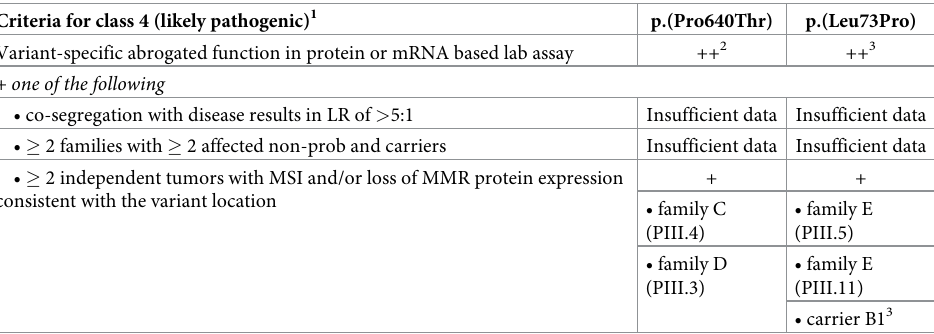
Table 2. Evaluation of the variants in terms of the InSiGHT variant classification criteria. Criteria for class 4 (likely pathogenic)